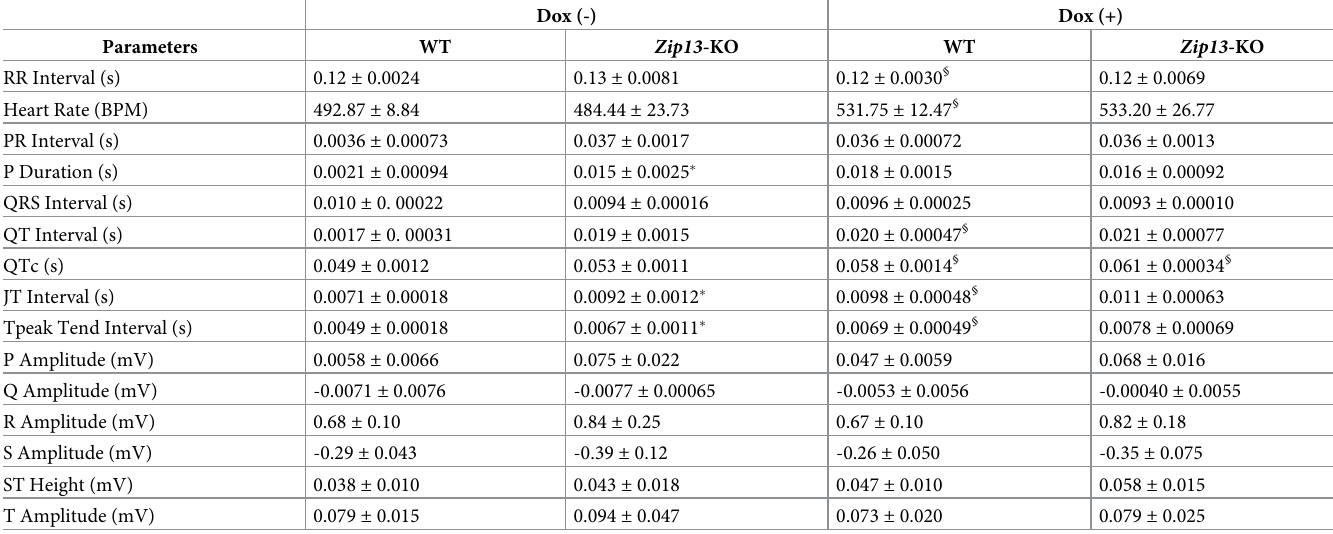
Table 1. Summary of telemetry ECG analysis of WT and Zip13 -KO mice.